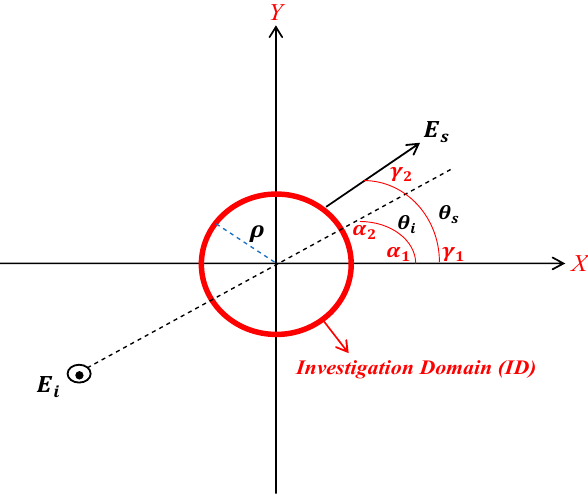
Figure 2. The geometry of the circumference ID.